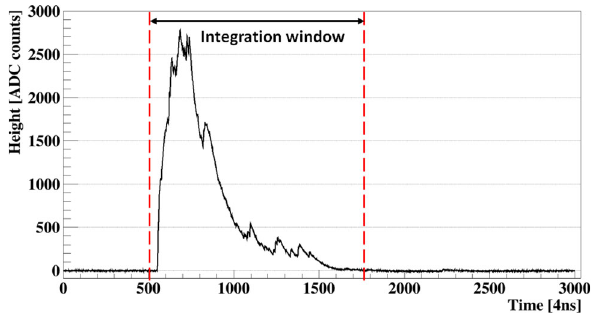
Fig. 9 A randomly selected light pulse within the 59.5 keV peak from the top SiPM. The ones from the bottom SiPM are very similar